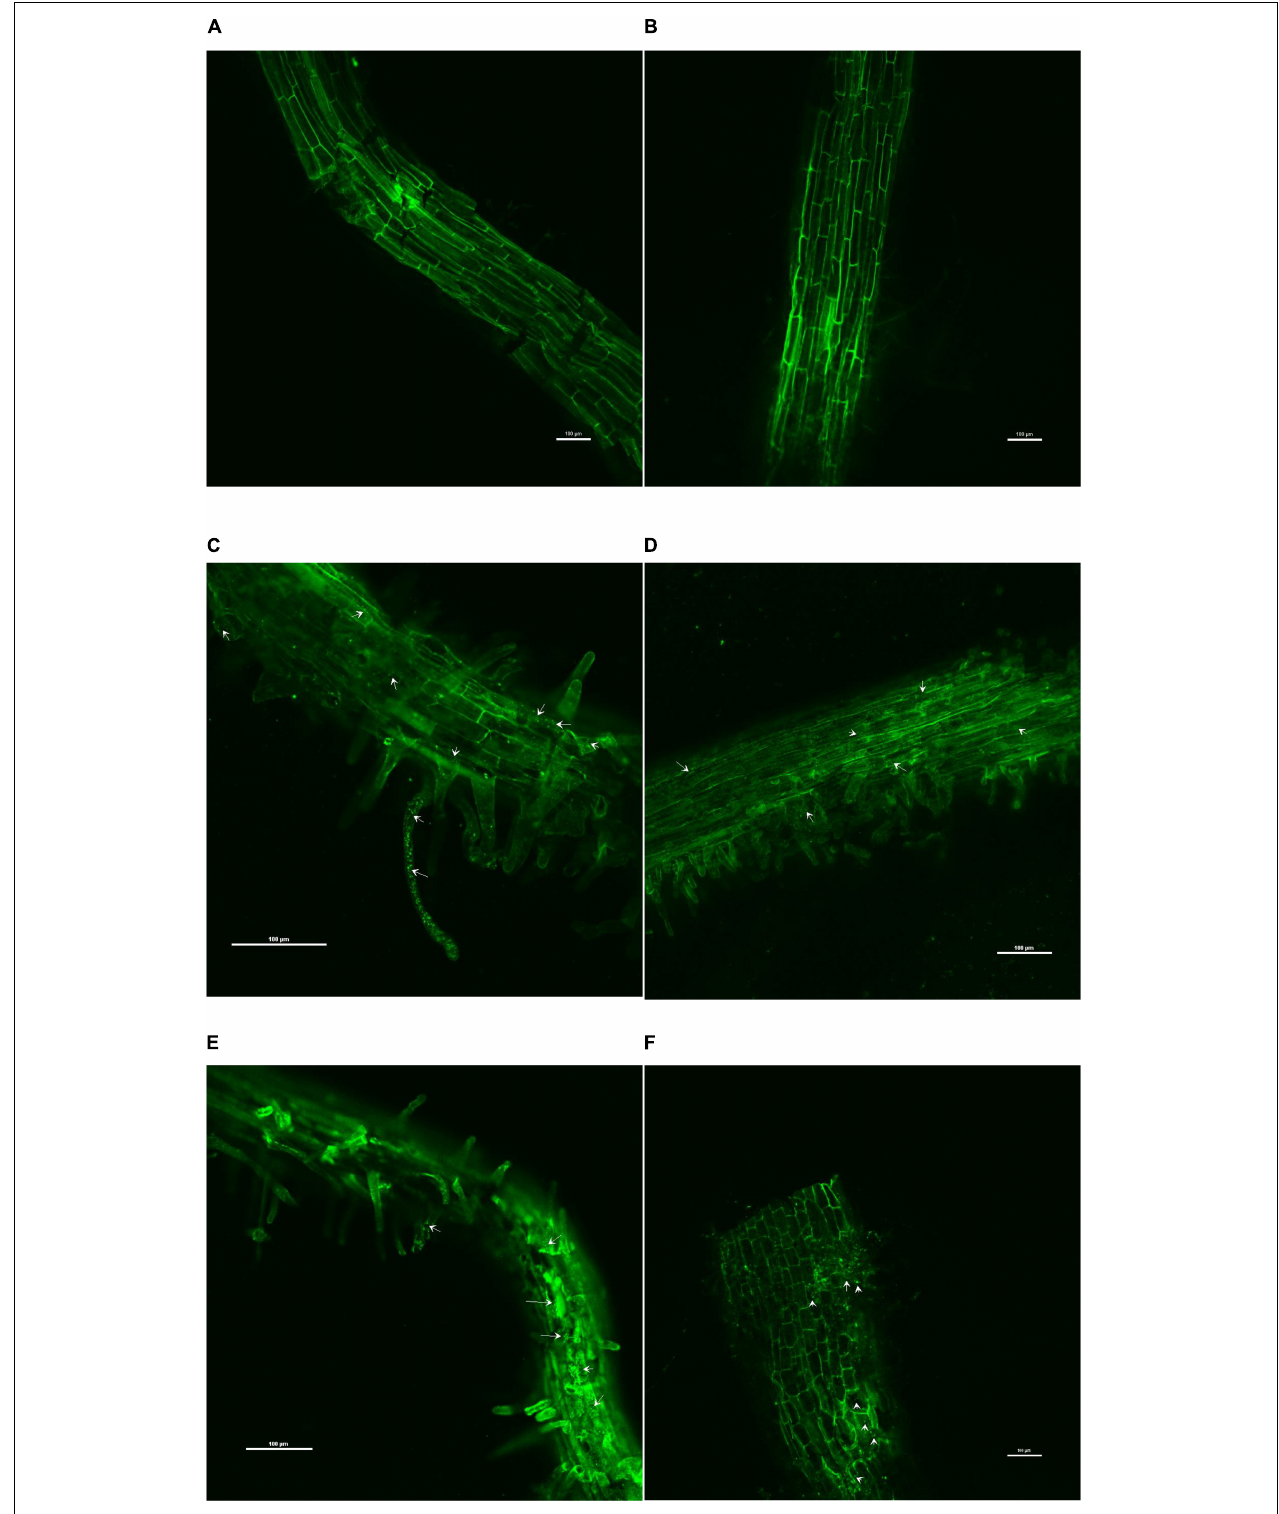
FIGURE 1 | Confocal scanning laser microscopy images showing the inter-genera colonization of Ocimum tenuiflorum bacterial endophytes in tomato roots treated with LIVE/DEAD TM Bac Light TM bacterial viability stain. The white arrows indicate live bacterial endophytes in tomato roots in different treatments. (A) absolute control, (B) saline control, (C) BTL5, (D) GTR8, (E) GTR11, and (F) GTS16.